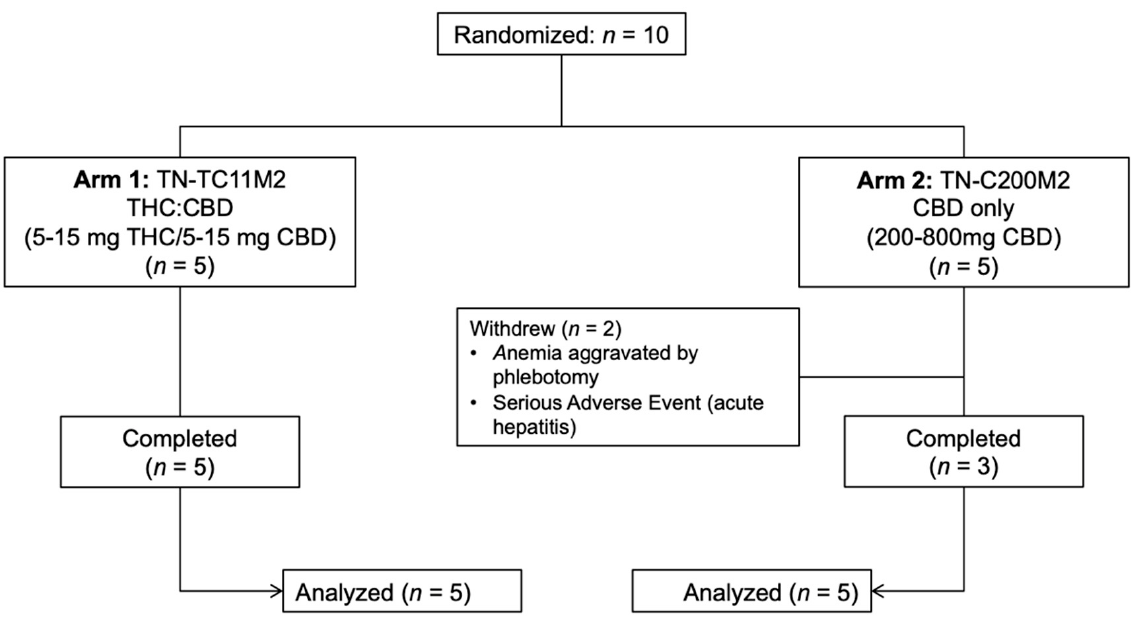
Figure 2. Allocation of participants enrolled in the study ( n = 10). Distribution of study participants randomized to arm 1 (TN-TC11M2; THC:CBD) or arm 2 (TN-C200M2; CBD-only), to the study.